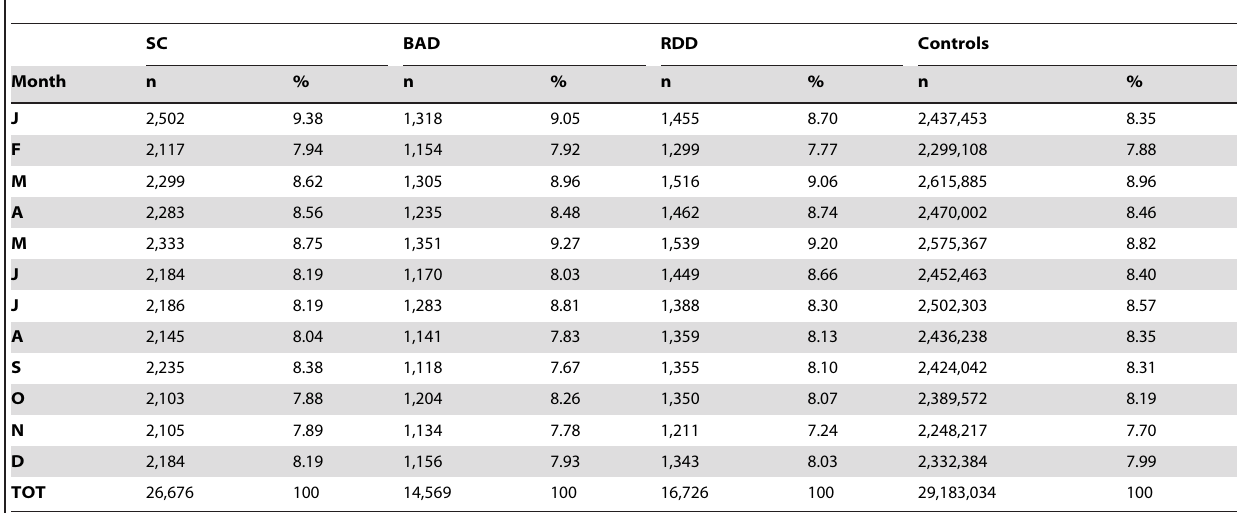
Table 1. Number and percentages of psychiatric and general population births.